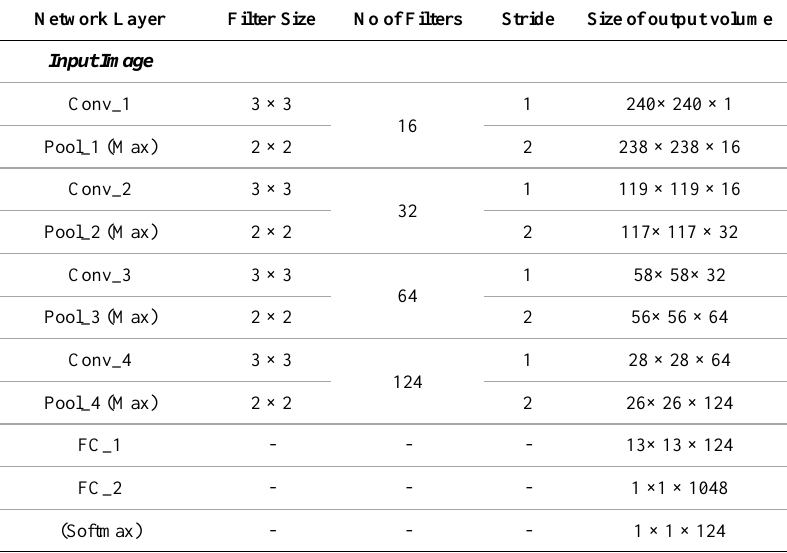
Table 1. Details of CNN Architectures for GEI Size (240 × 240)